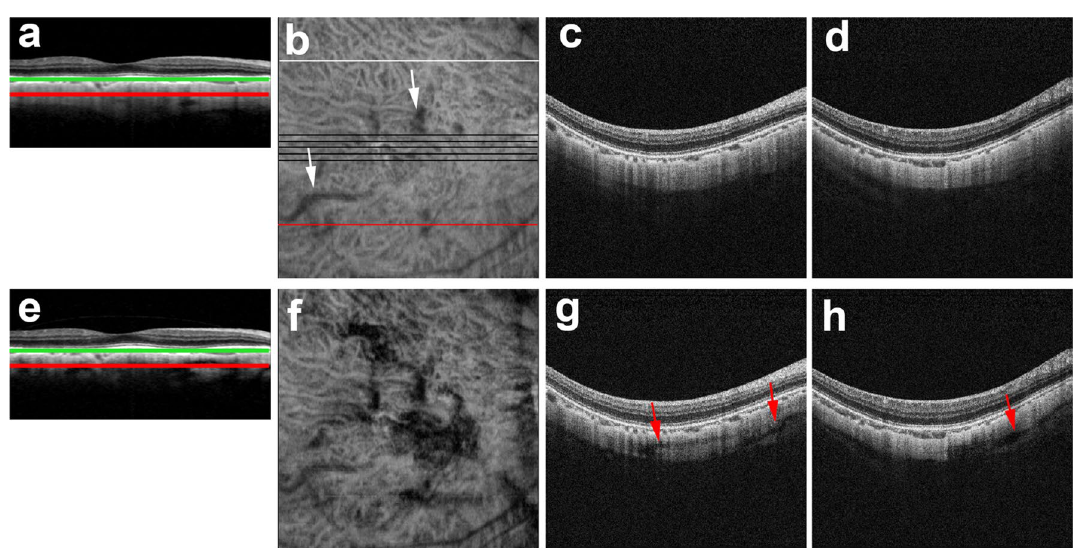
Figure 7. En face scleral PD-OCT images of the eye in Fig. 4. Polarization-independent OCT images (a–d) and polarization-dependent OCT images ( e – h ). PD-OCT B-scan images ( a , e ) were flattened with respect to Bruch’s membrane (green lines) to generate a reference plane (red lines) for en face scleral images ( b , f ). En face scleral image of polarization-independent OCT ( b ) shows real scleral vessels (white arrows) in the shadows of choroidal structures. Black lines indicate five sets of macular scan lines. White line indicates the upper scan line ( c , g ) and red line indicates lower scan line ( d , h ). En face scleral image of polarization-dependent OCT image ( f ) shows the distribution of artifactual low-intensity areas. By comparison with polarization-independent OCT B-scan images in upper ( c ) and lower ( d ) scan lines, scleral vessel artifacts in polarization-dependent OCT B-scan images are identified in both upper ( g ) and lower ( h ) scan lines (red